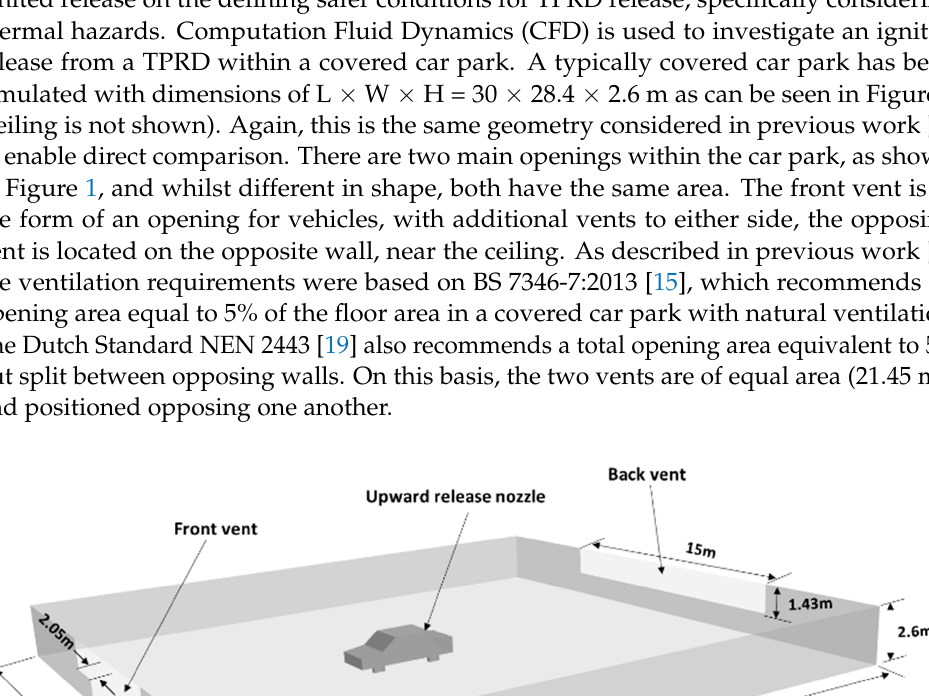
wheels were represented as a square of the same